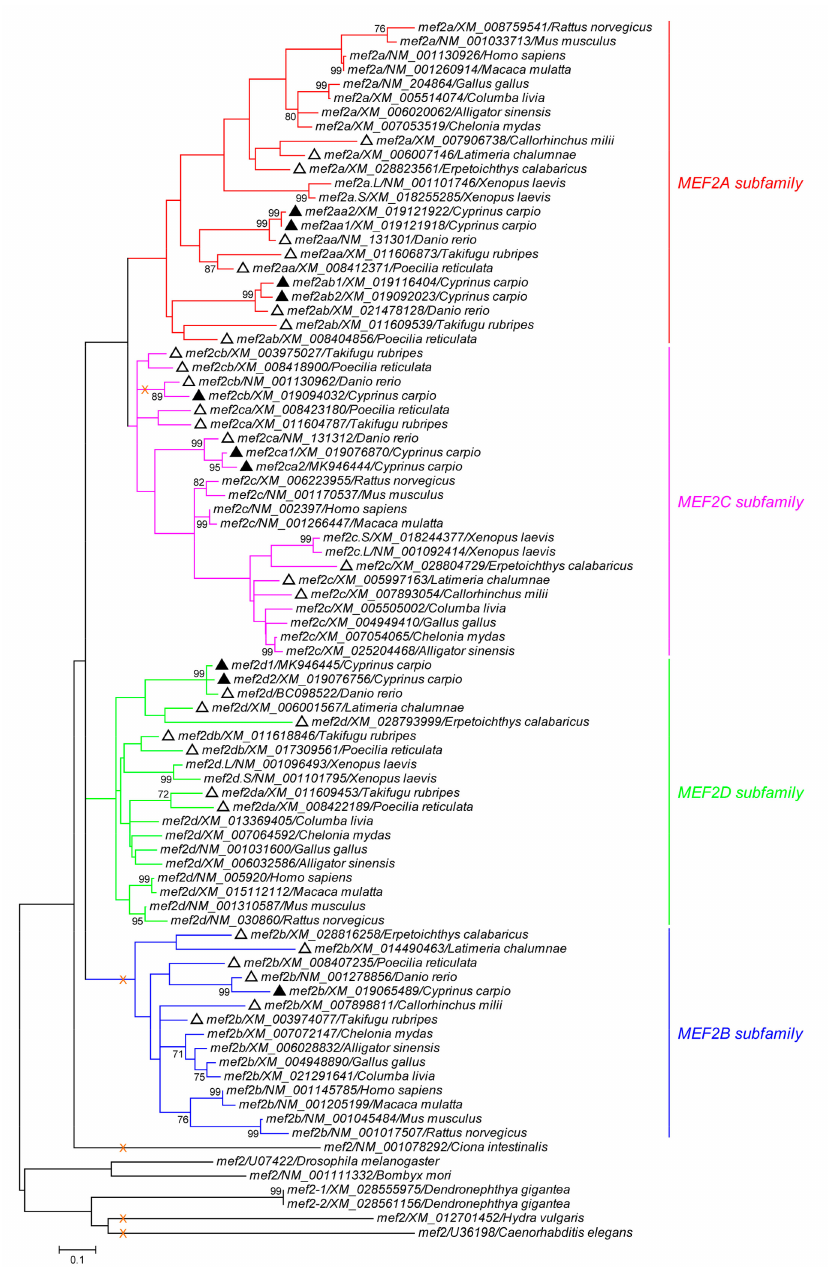
Figure 2. Phylogeny of the MEF2 family. The maximum likelihood tree was constructed based on the mef2 coding region 1–258. Information of each sequence used is given as name / accession / species. The scale bar indicates the number of nucleotide substitutions per site. Branches supported by > 70% bootstrap value (1000 replicates) are labeled, and those lacking the HJURP_C domain are indicated with "X". The four vertebrate MEF2 subfamilies are highlighted. The sequences of C. carpio and the other fish species are marked with " (cid:78) " and " (cid:52) ",